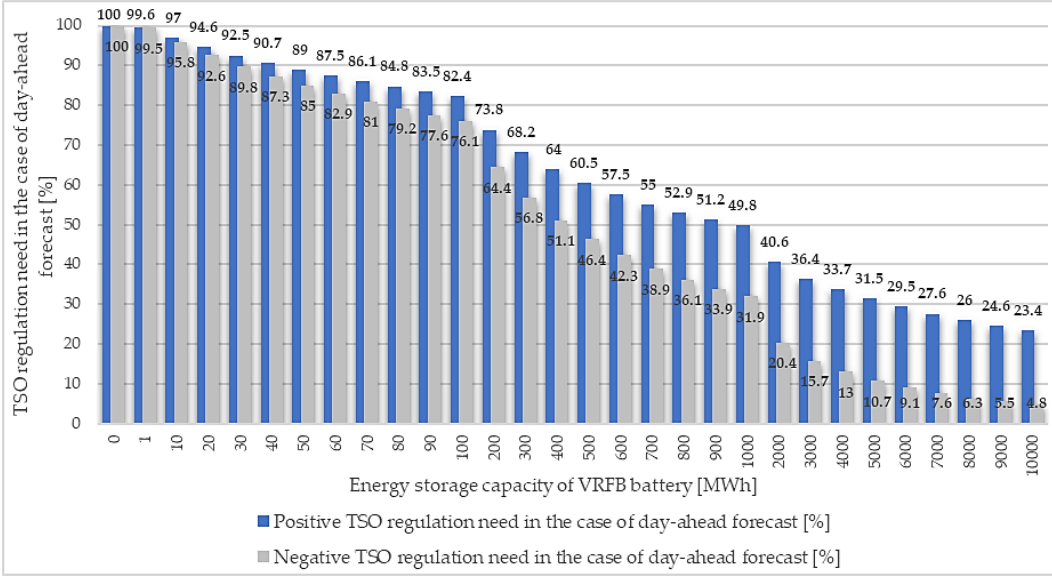
Figure 10. Negative and positive TSO regulation needs in the case of day-ahead forecast with different VRFB energy storage capacities related to a 1000 MWp PV system for the period of 30/09/2014– 30/09/2019.